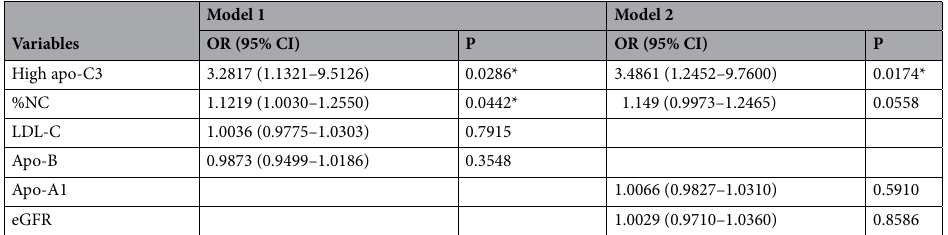
Table 7. Multivariate logistic regression analysis of predictors of 4-year MACEs, adjusted for major confounders. MACE Major cardiovascular event; OR odds ratio; CI confidence interval; apo-C3 apolipoprotein C3; high apo-C3 patients with apo-C3 > 8.5 mg/dL; %NC, percentage of plaque volume that is a necrotic core; LDL-C Low-density lipoprotein cholesterol; eGFR Estimated glomerular filtration rate. *The value of OR is statistically significant with P <